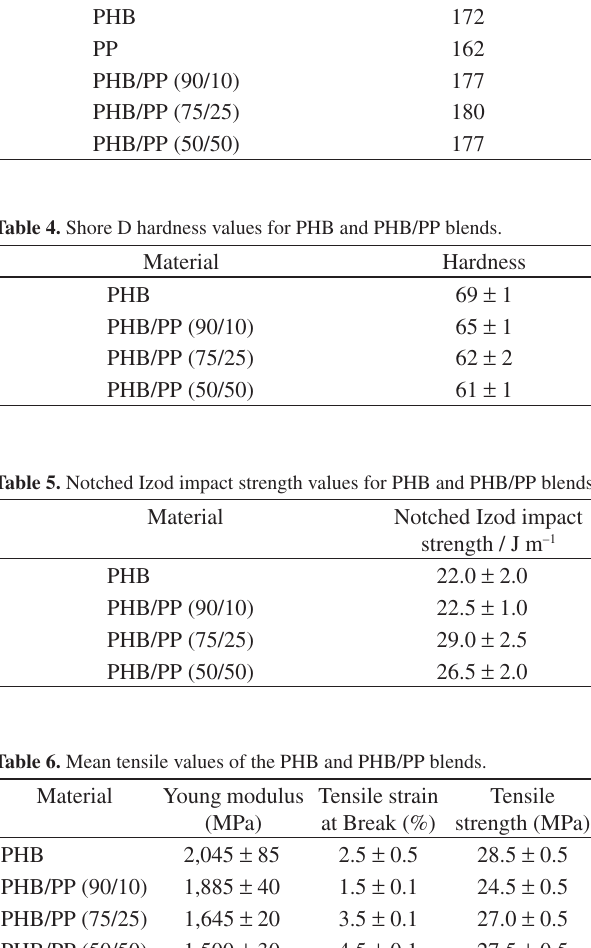
Figure 4. Notched Izod impact strength values of PHB and PHB/PP blends.